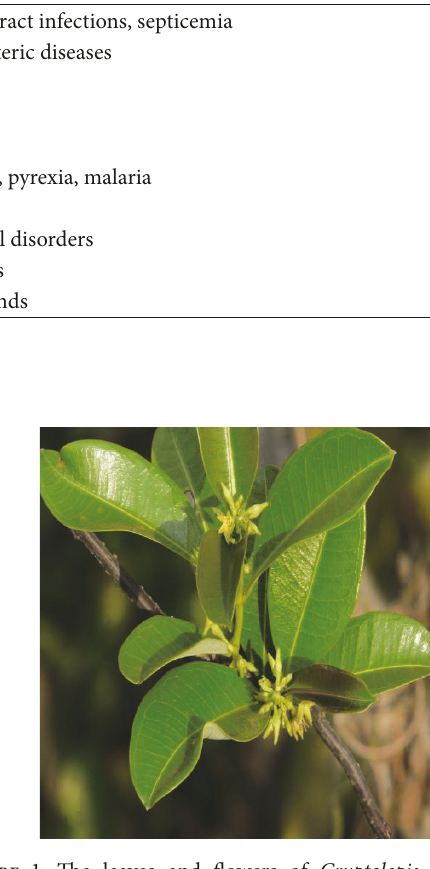
Figure 1: The leaves and flowers of Cryptolepis sanguinolenta (adapted from the Useful Tropical Plants Database,